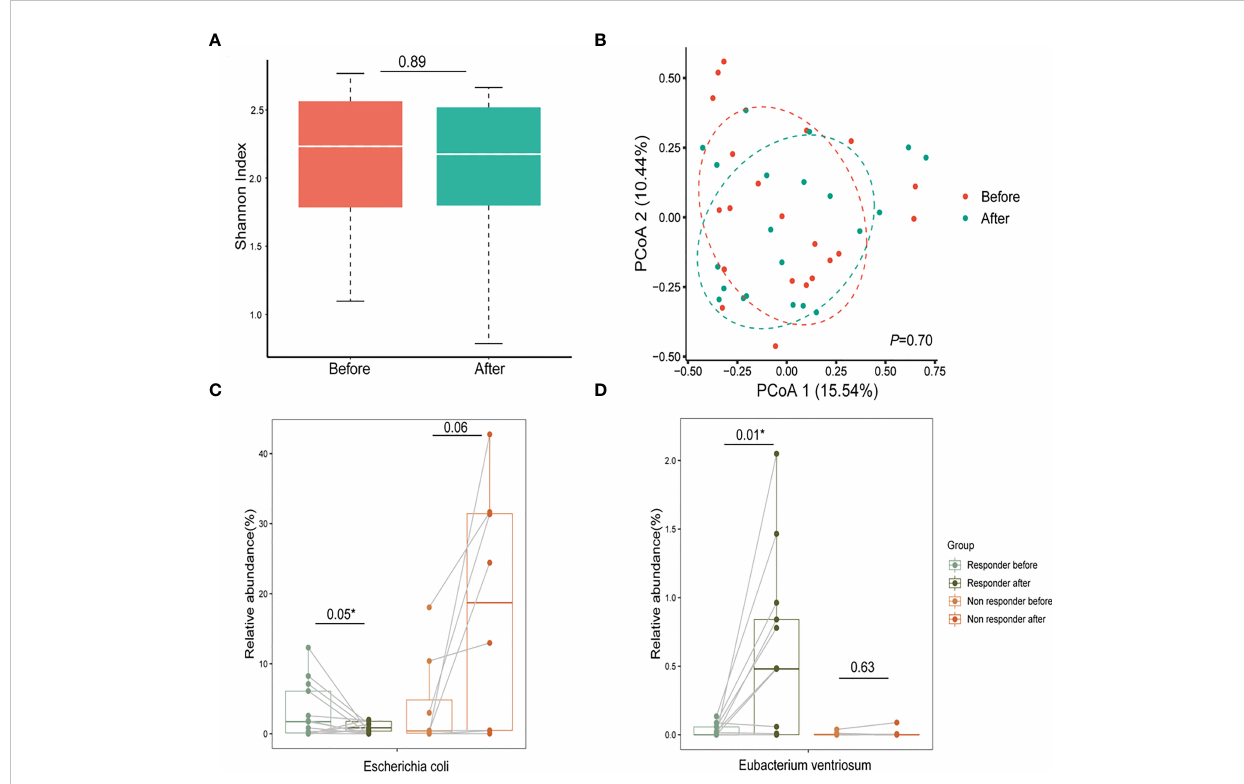
FIGURE 3 Glucocorticoids aid in reestablishing a healthy gut microbiome in patients with PV. (A, B) The a -diversity and b -diversity of the gut microbiome in the pre-treatment and post-treatment groups; (C) After one month of glucocorticoid therapy, Escherichia coli decreased in relative abundance in the responder group and increased in the non-responder group (* represents statistical signi fi cance with the P value <0.05 using paired t-test); (D) The relative abundance of probiotics ( Eubacterium ventriosum ) reduced in the PV group increased after treatment with glucocorticoids (*represents statistical signi fi cance with the P value <0.05 using paired t-test). PV, pemphigus vulgaris; PCoA, principal coordinates